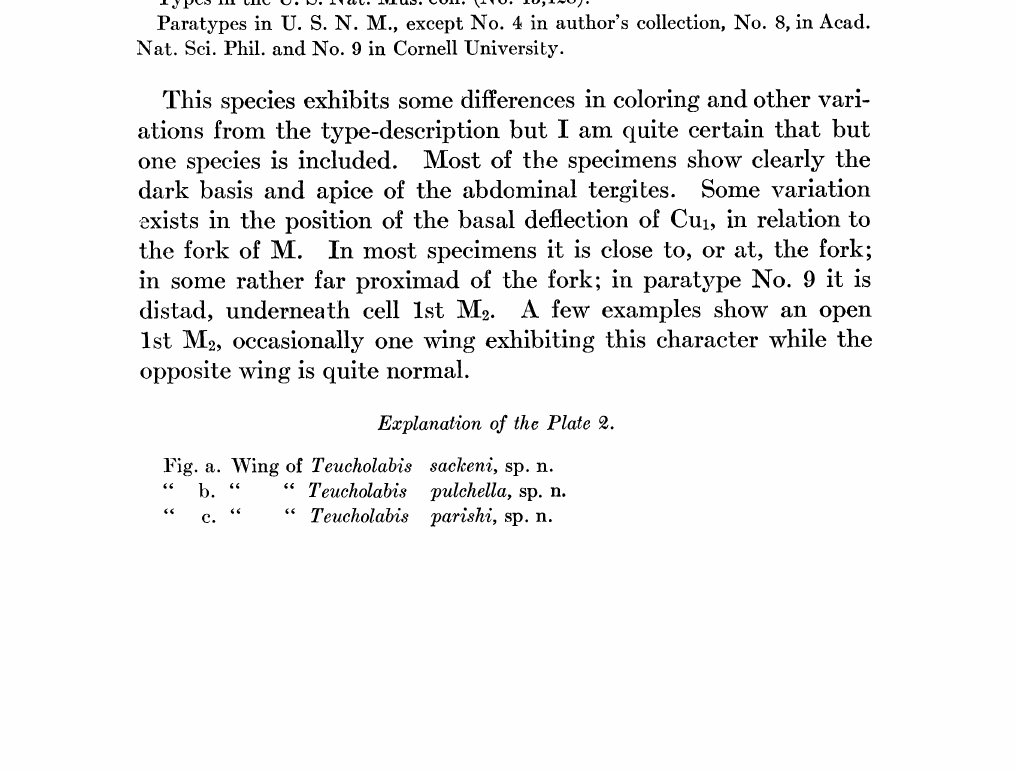
Fig. a. Wing of Teucholabis sackeni, sp. n.